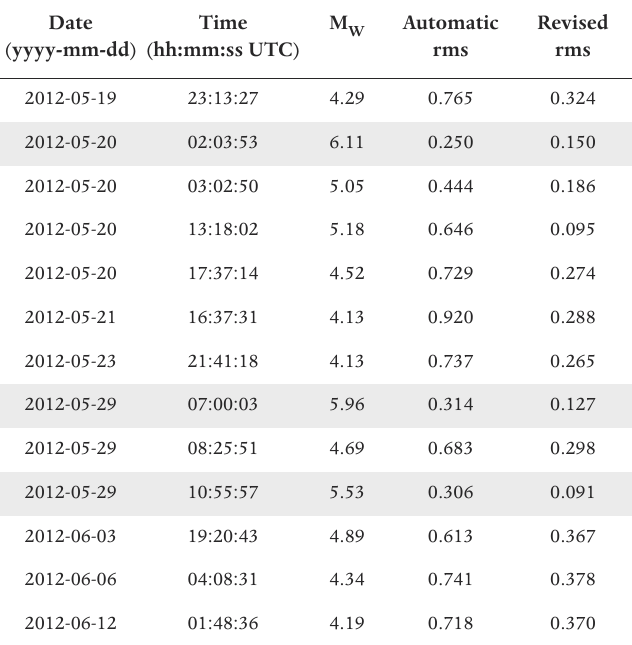
Table 3. Information on the automatic and rapidly revised